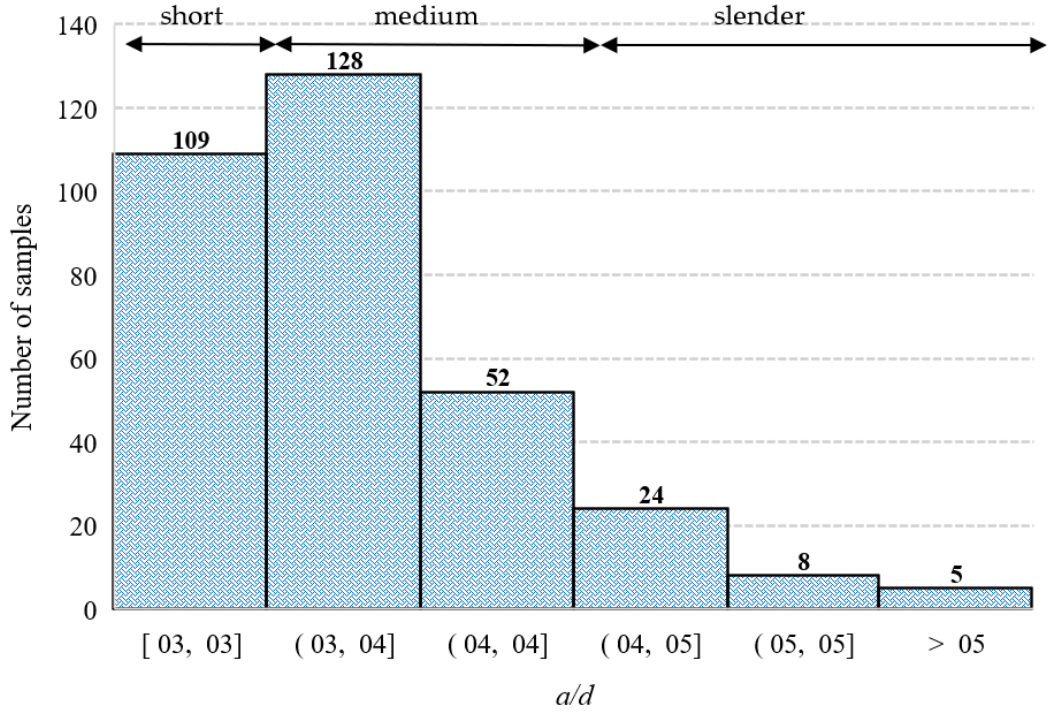
Figure 5. Histogram of a / d for the full database. Table 5. Model uncertainty statistics for different subsets of beams.